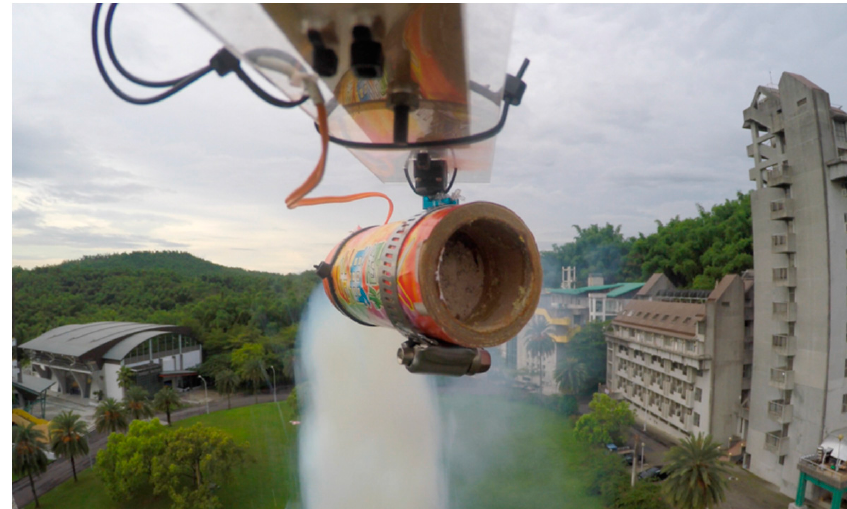
Figure 9. The smoke tube shifted to the right.